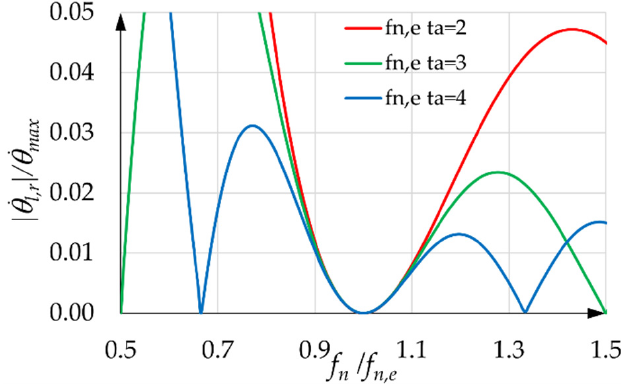
k equal to one and j